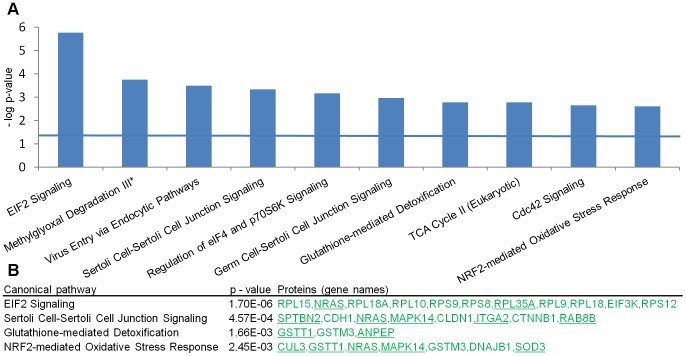
Canonical pathways associated with the proteins meeting the fold-change criteria.A. The top scoring (lowest p-values) canonical pathways associated with the differentially expressed proteins found in the pairwise comparisons between the four keratinizing tissues. *The second highest score "Methylglyoxal Degradation III" was found in the comparison between tympanic membrane and EACS. All others were found in the comparison between cholesteatoma and EACS. Horizontal blue line indicates p value  = 0.05. B. p values and the involved differential-level proteins of three selected pathways from the comparison between cholesteatoma and EACS. All proteins showed lower levels (green color) in cholesteatoma compared with EACS. Underlined proteins: Group B proteins.